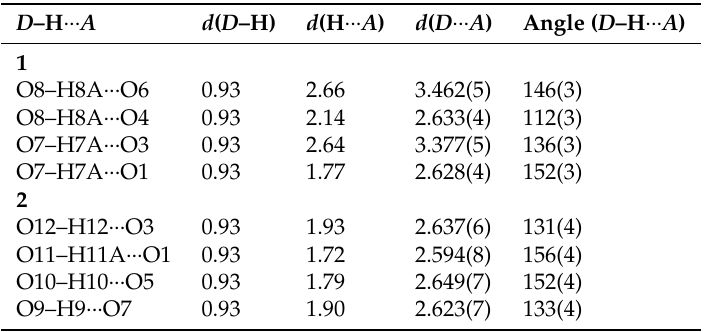
Table 3. Hydrogen bond distances (Å) and bond angles (°) for complexes 1 and 2 .